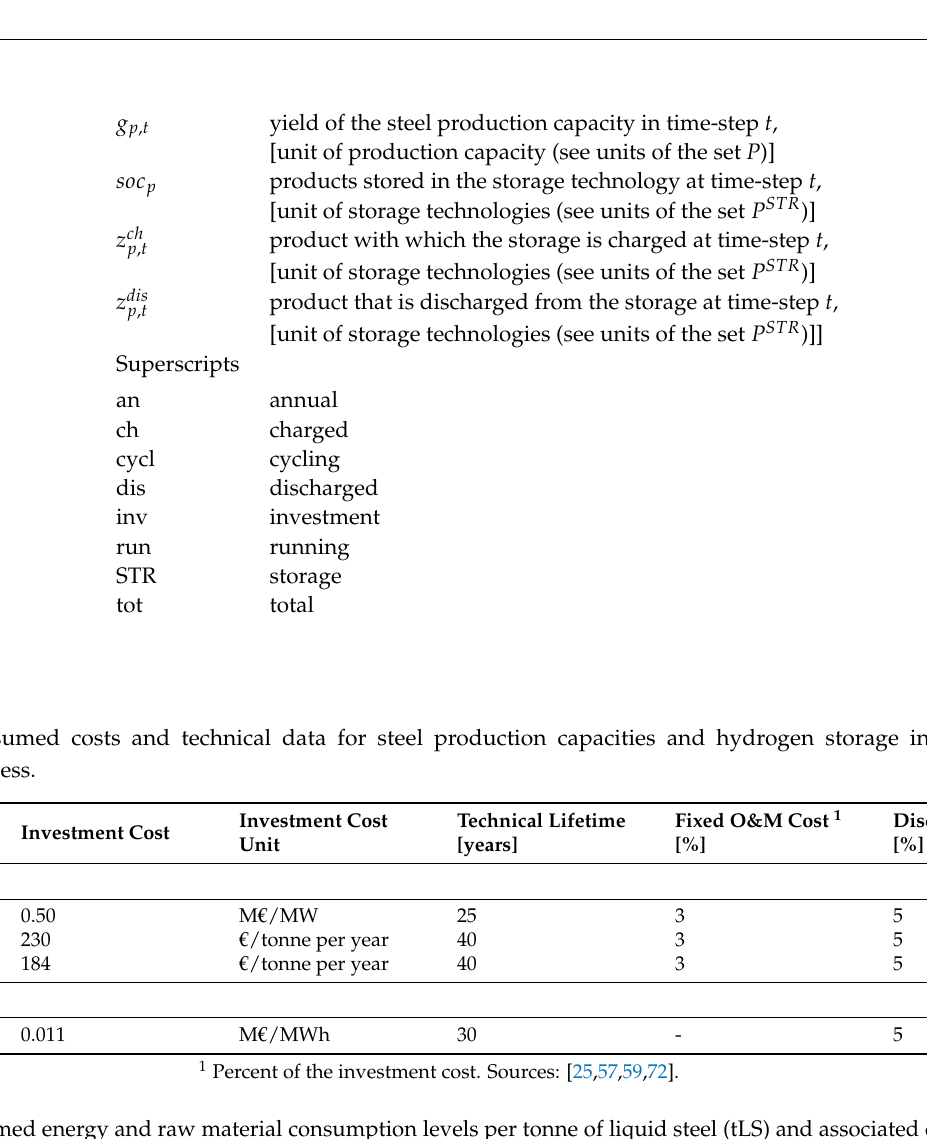
Table A2. Assumed energy and raw material consumption levels per tonne of liquid steel (tLS) and associated costs for the H-DR production